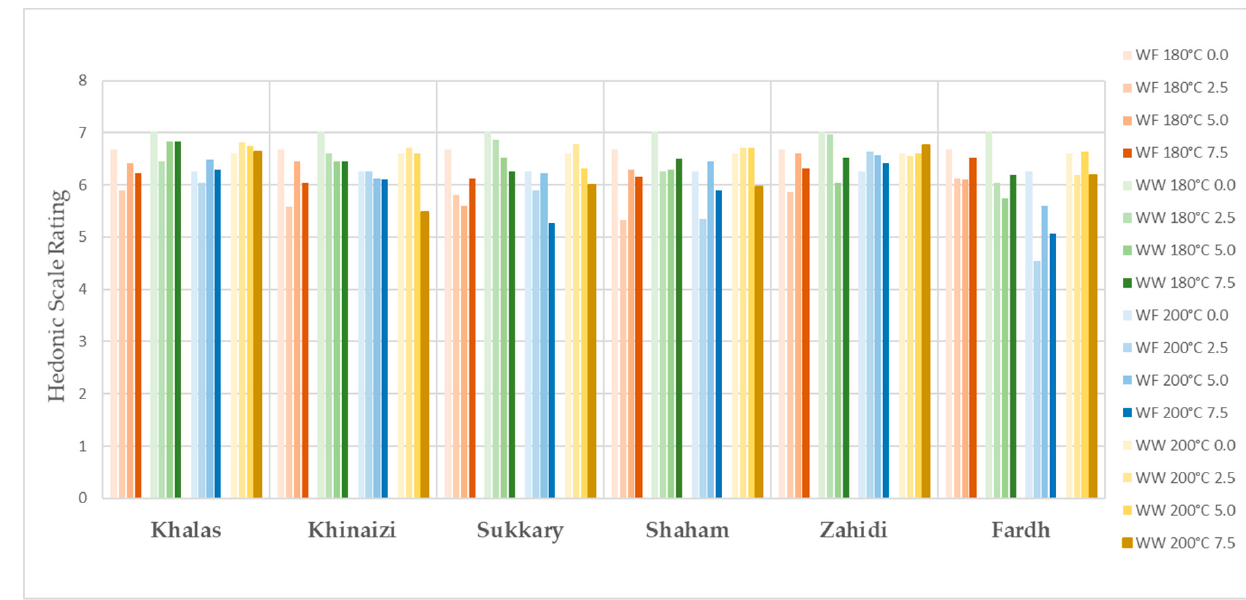
Figure 2. Colour evaluation for date seed composite cookies.